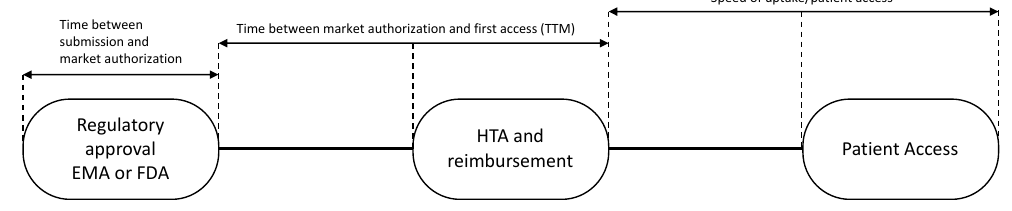
Figure 1. Patient newly registered drug access pathway. EMA: European Medicines Agency; FDA: USA Food and Drug Association; HTA: health technology assessment; TTM: time to market.